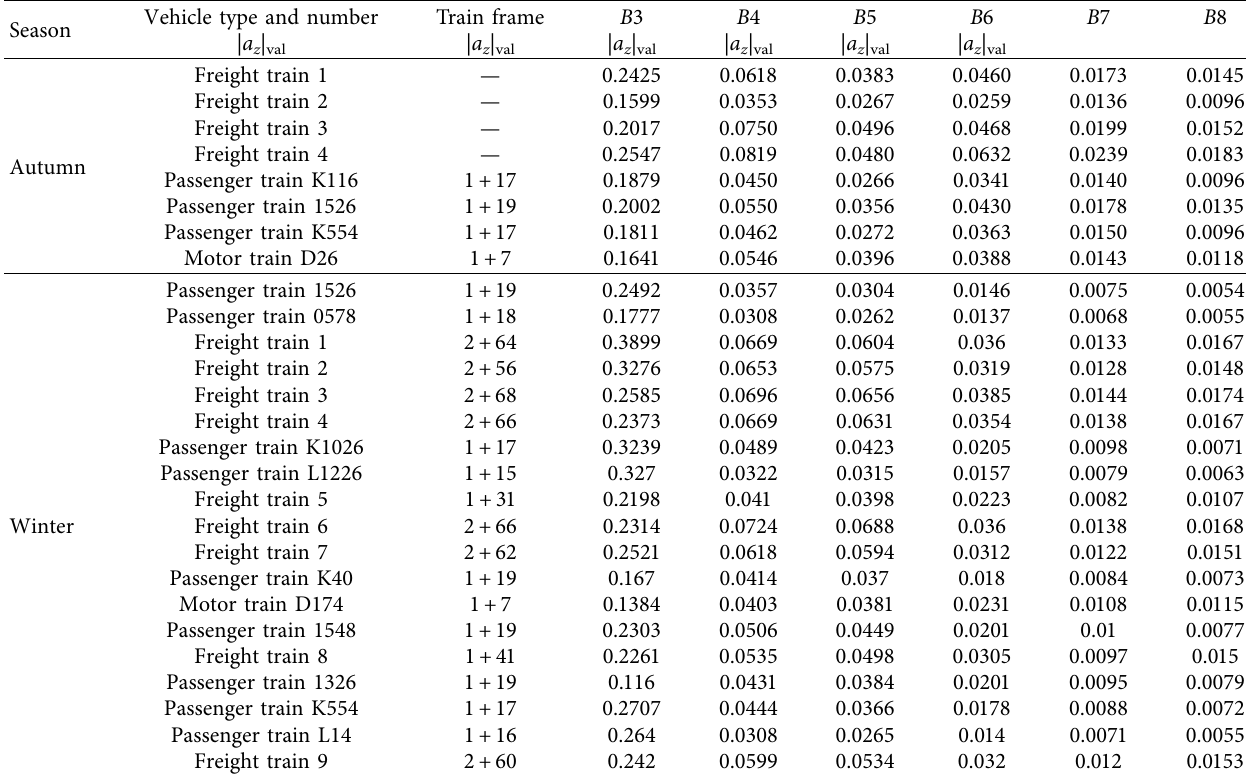
Table 1: Amplitude statistics of subgrade vibration acceleration from trains at the k1229 +135 section of the Beijing–Harbin railway. Vehicle type and Season